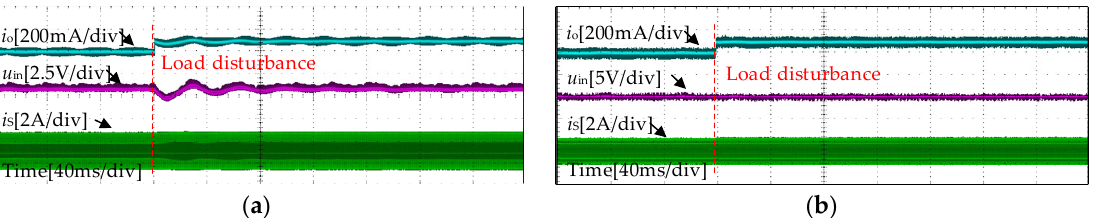
Figure 15. Experimental waveforms when Uin is changed from 100 V to 130 V: ( a ) with the traditional constant compensation control method; ( b ) with the proposed VDCC method.